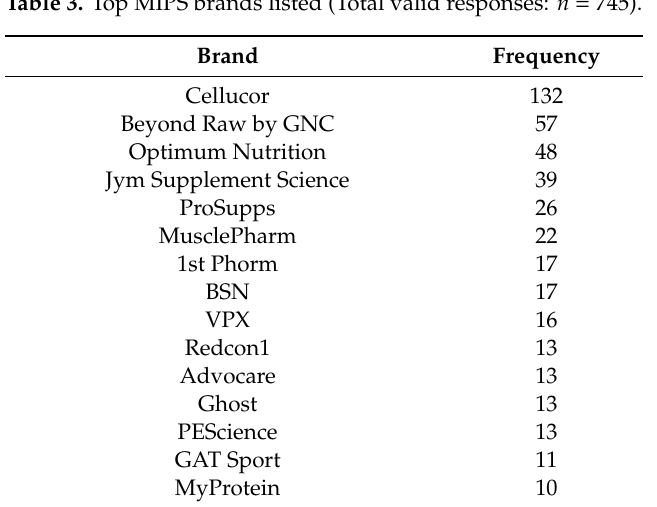
Table 3. Top MIPS brands listed (Total valid responses: n =